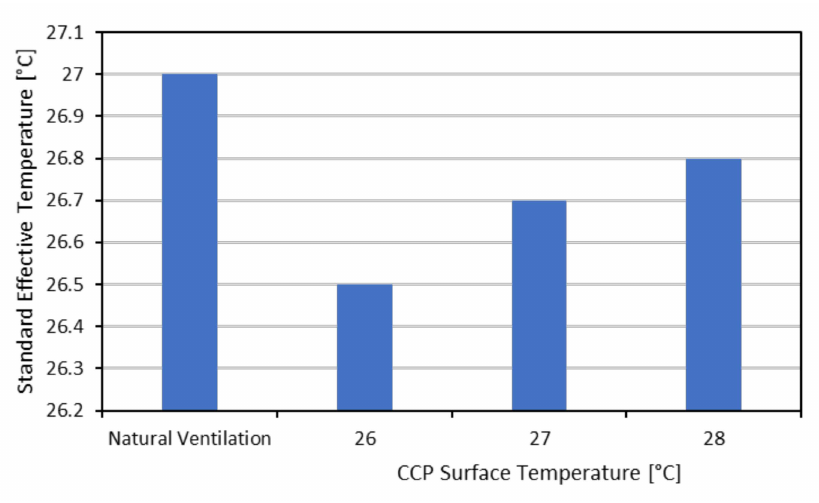
Figure 4. Standard effective temperatures of the four cases.